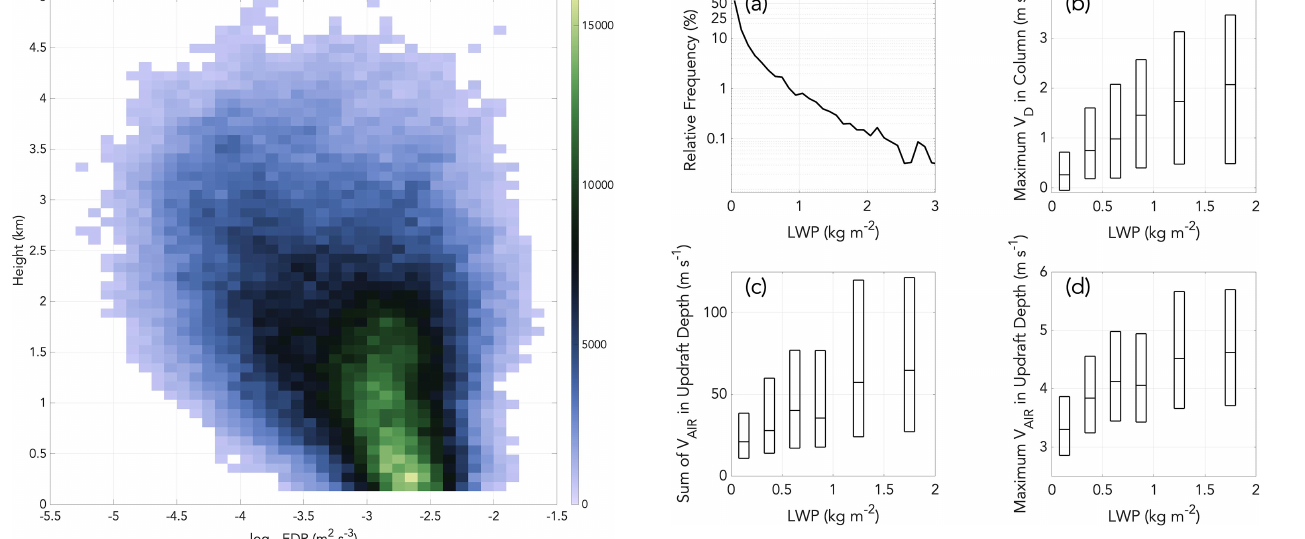
Figure 6. For all 13 COMBLE cases, a joint PDF of eddy dissipa- tion rate versus height. Prepared using Crameri (2021).